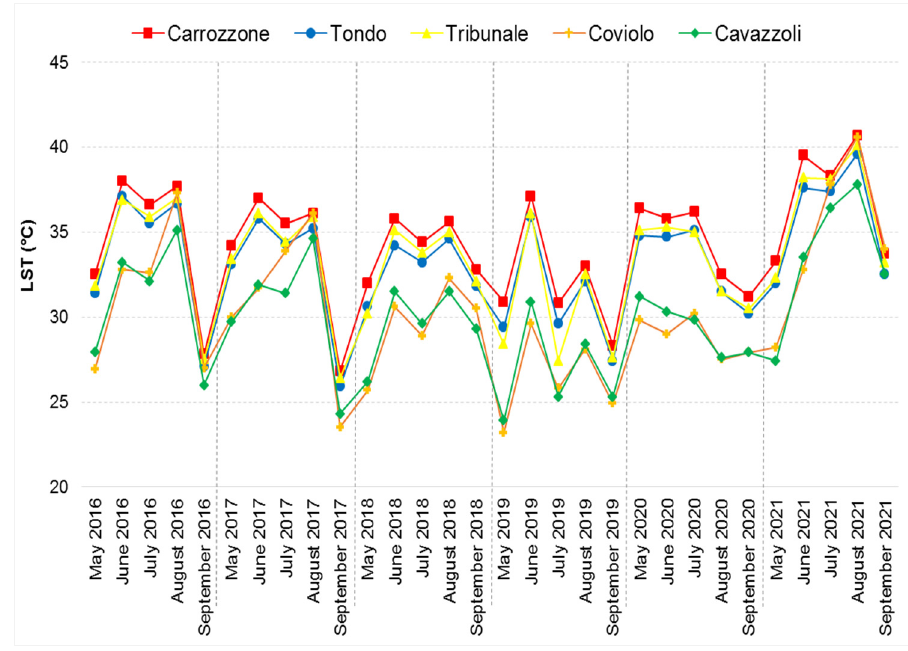
Figure 6. Mean temperature of the five LCZs retrieved for each LST map (2016-2021). Figure 6 confirms the evaluations made by photointerpretation: the industrial areas have higher LST values than the surrounding rural areas. Higher temperatures are re- trieved in the summer months, i.e., in June, July, and August, while in May and September the average temperatures are lower. In August 2016, 2017, and 2021, the average temper-